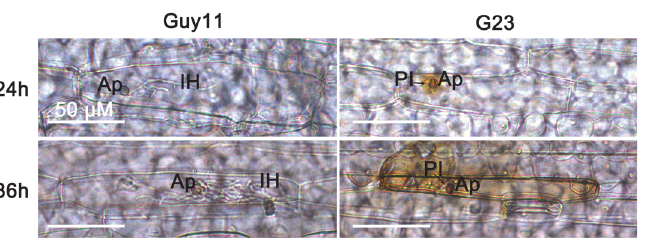
Fig 7. Detection of H 2 O 2 accumulation at infected barley cells. Detached barley leaf were inoculated with the tested strains, stained with DAB at 24 and 36 hpi, and observed under the light microscope. The cells infected by MoSFA1 deletion mutant were strongly stained with DAB, indicating high H 2 O 2 accumulation at the penetration site. Bar is 50 μ m. Ap, appressorium; PI, primary infectious hyphae; IH, secondary infectious